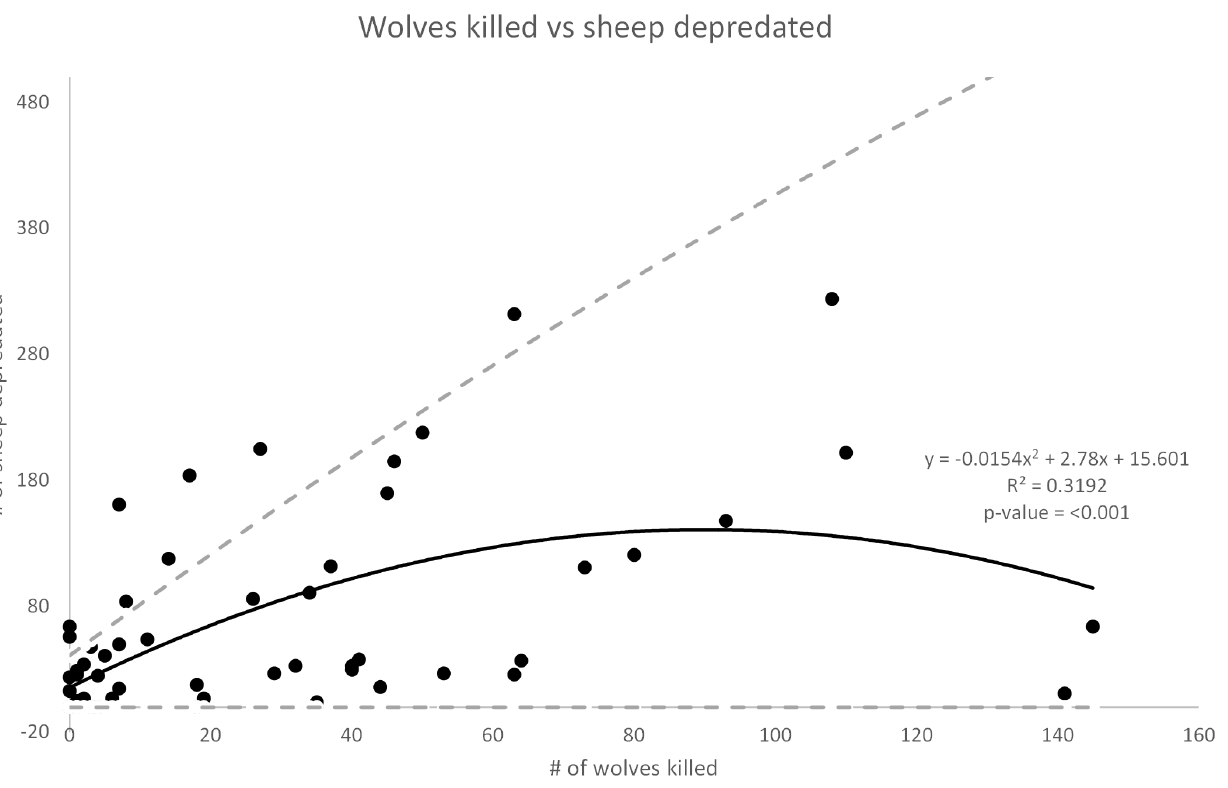
Figure 4. Wolves killed vs sheep depredated. Number of wolves killed through control methods the previous year versus the number of sheep depredated the following year. The dashed lines show the upper and lower limits of the 95% confidence interval for the best fit